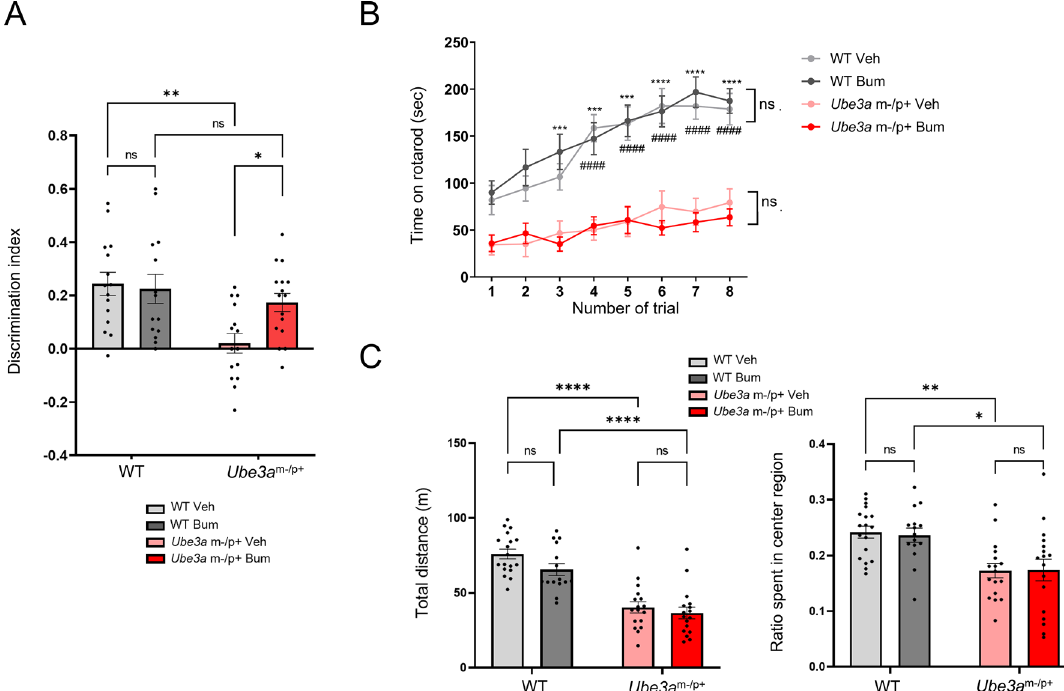
Figure 3. Effects of chronic bumetanide administration on behavioral test results in Ube3a m−/p+ mice. ( A) Effects of bumetanide on the results of the novel object recognition test. ns not significant, * p < 0.05; ** p < 0.01 by post-hoc analysis after two-way ANOVA. n = 14–16 for each group. ( B ) Effects of bumetanide on the performance of mice in the accelerating rotarod test. ns notsignificant between treatment with bumetanide (Bum) and vehicle control (Veh). *** p < 0.001; **** p < 0.0001 for wild-type (WT) Veh versus Ube3a m−/p+ Veh. ####: p < 0.0001 for WT Bum versus Ube3a m−/p+ Bum by post-hoc analysis after three-way repeated-measures ANOVA. n = 15–18 for each group. ( C ) Effects of bumetanide on the results in the open field test. The left and right panels show the total distance traveled and ratio time spent in the center region, respectively. ns not significant. * p < 0.05; ** p < 0.01; **** p < 0.0001 by post-hoc analysis after two-way ANOVA . n = 15–18 for each group. The open field and rotarod test results are not affected by bumetanide, but bumetanide restores the low discrimination index of Ube3a m−/p+ mice in the novel object recognition